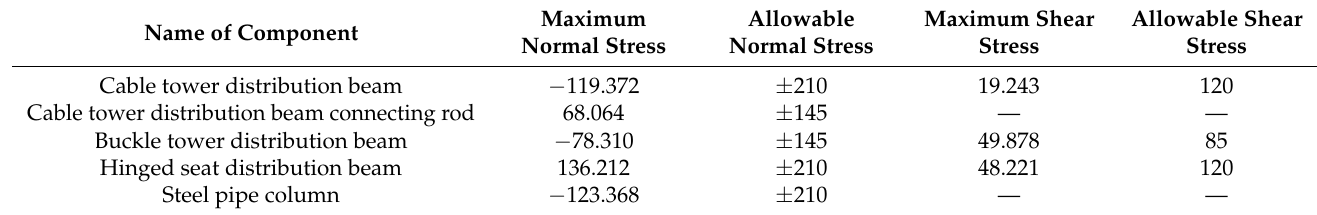
Table 11. Stress of main components of tower (unit: MPa).